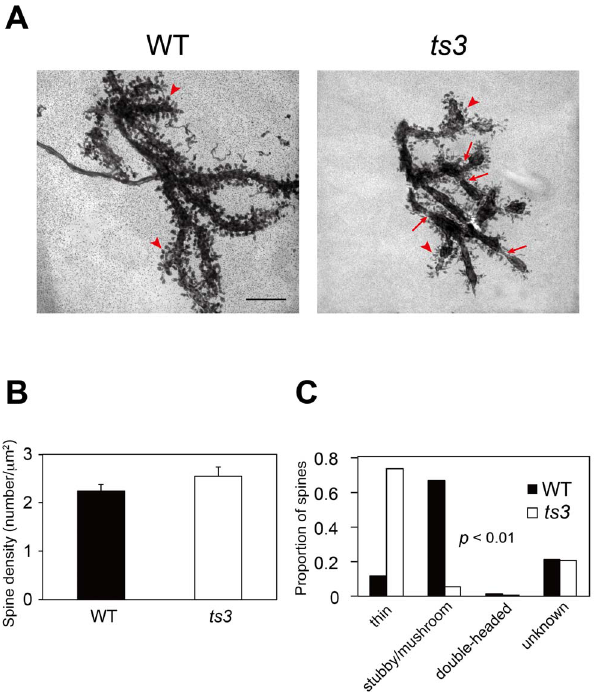
Figure 5. ts3 purkinje cells demonstrate a characteristic of senescent cell as observed by electronmicroscopy. Electron photomicrographs of PC cells in 30-week-old WT ( A , B ) and ts3 ( C , D , E ). Lipofuscin accumulation in cell bodies (arrowheads in B and C ), representing senescent postmitotic neurons, was observed in ts3 , but not in WT PC cells. Scale bars, A, B, 5 m m; C, D, 2 m m; E, 0.5 m m.